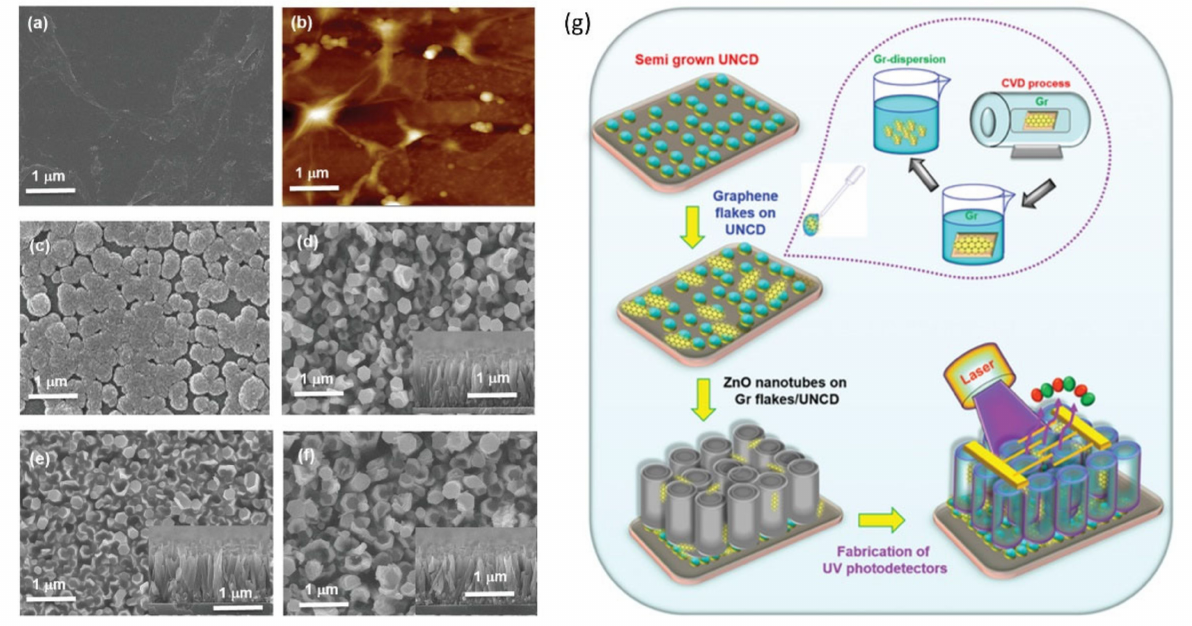
Figure 5. High-performance photodetector based on GN flakes, UNCD and ZnO nanotubes. ( a ) FESEM image of GN layer, ( b ) AFM image of GN layer, and ( c ) FESEM images of semigrown UNCD materials grown for 5 min. ( d )–( f ) FESEM images of UNCD-ZNT, GrF-ZnTs, and GrF-ZnTs/UNCD heterostructures. ( g ) Fabrication flow diagram of the UV photodetector. Reprinted with permission from [152]. Copyright 2020 John Willey and